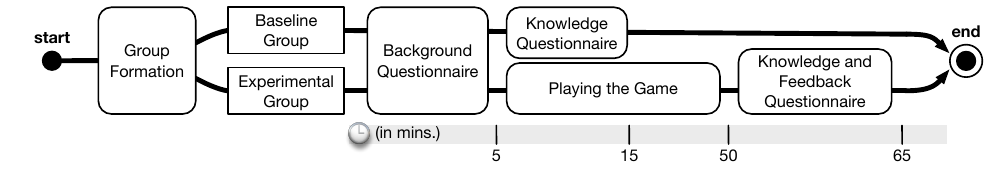
Figure 6. Experiment